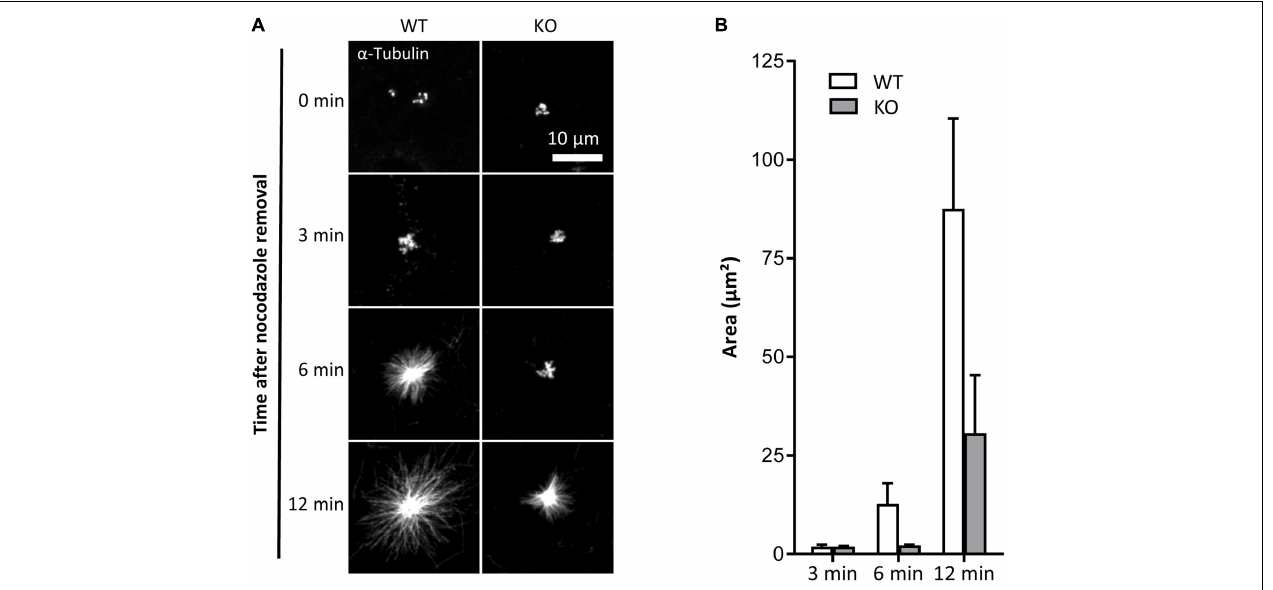
FIGURE 2 | TUBB6 depletion affects MT polymerization. (A) Representative MIP images of WT and KO osteoclasts stained for α -tubulin, after release from nocodazole and cold treatment for indicated times. (B) Bar graph showing mean and SEM of α -tubulin aster area in WT and KO osteoclasts treated as in (A) , 80 WT and KO asters in four independent